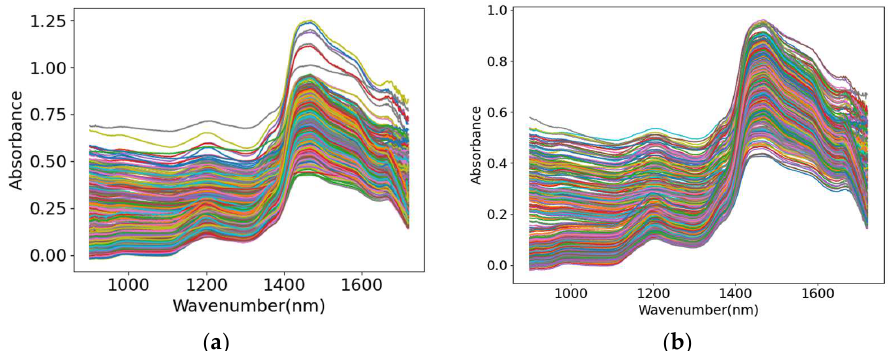
Figure 7. Spectral wavelengths of three coniferous wood: ( a ) Before the rejection of outlier sample; ( b ) After the rejection of outlier sample.